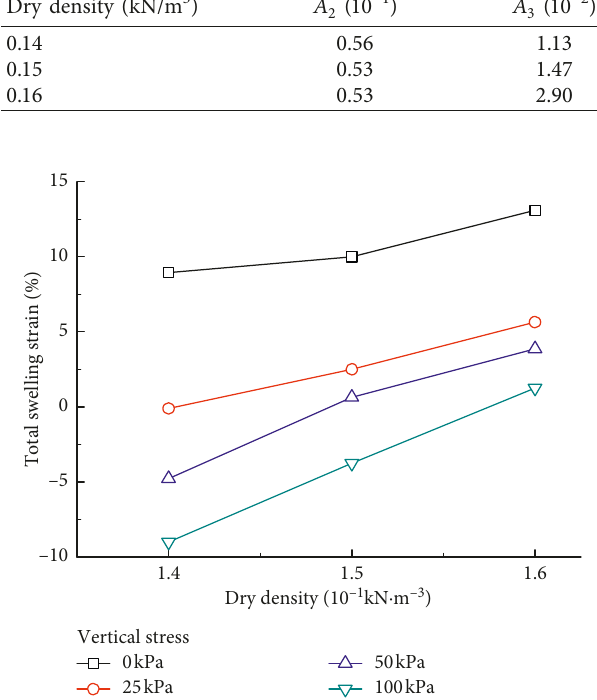
Figure 8: Relation between the swelling strain and dry density for the moisture content of